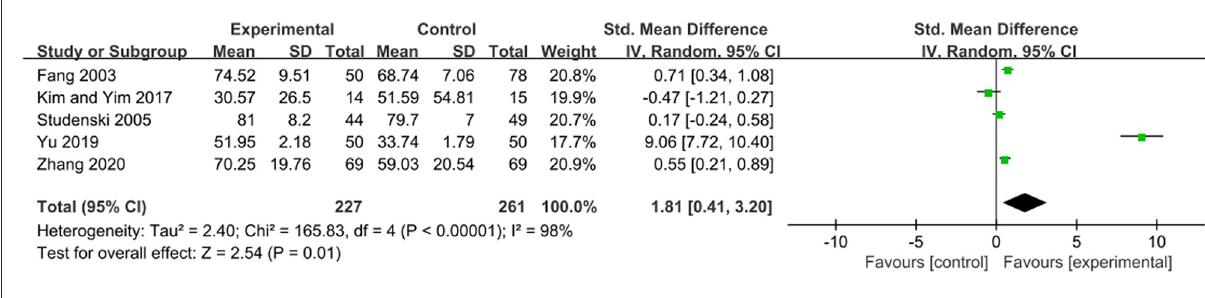
FIGURE5 Effects of exercise therapy on monitor function in patients with PSCI.